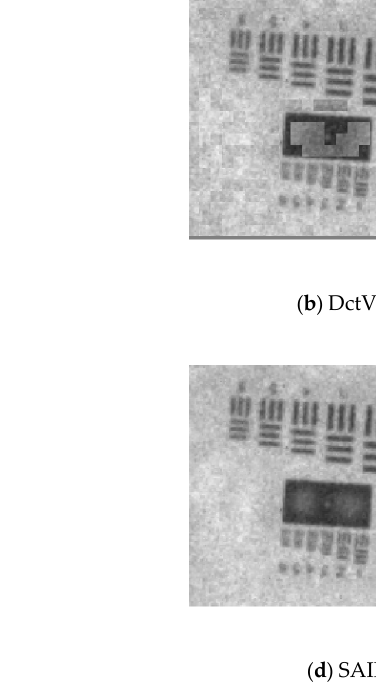
Figure 15. The fusion result of the NVG image (60 and 96 degrees).